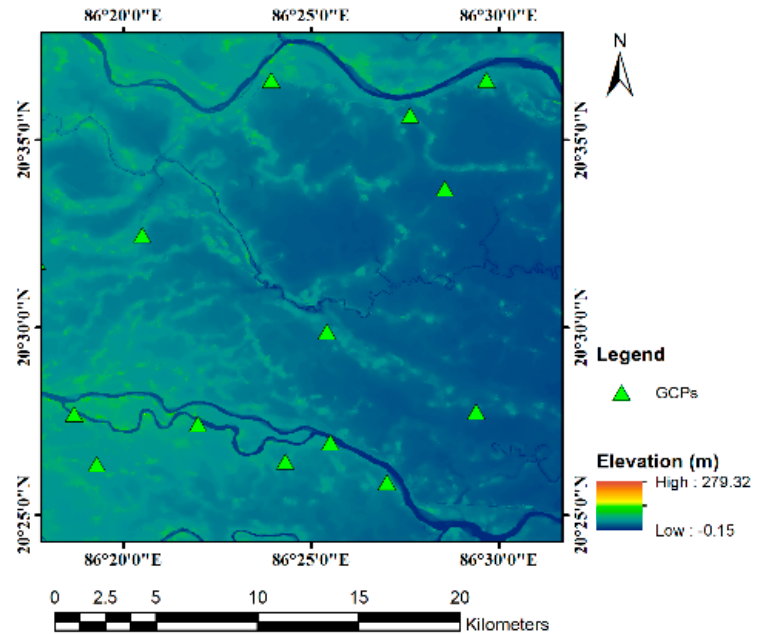
Figure 2. FABDEM for Kendrapara site.